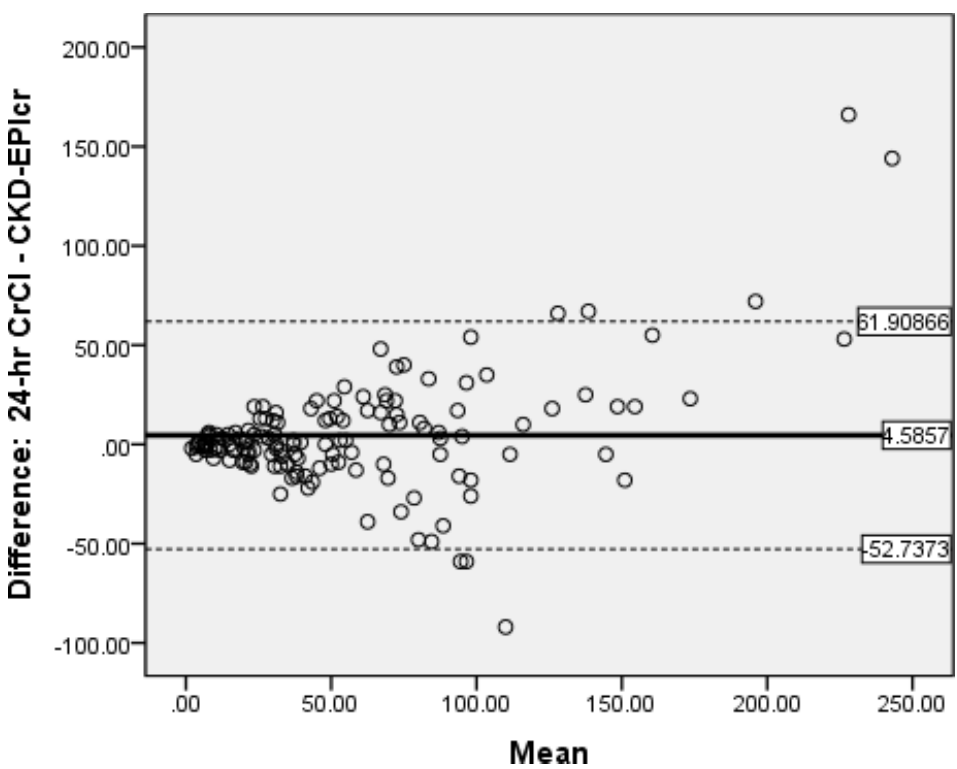
Figure 4. Bland-Altman plot of CKD-EPIcrea vs. CrCl.